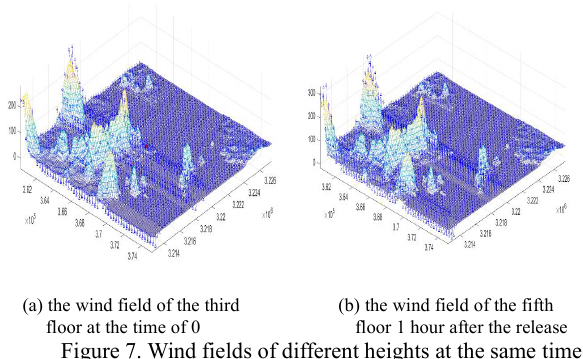
Figure 9. Comparison of plume results